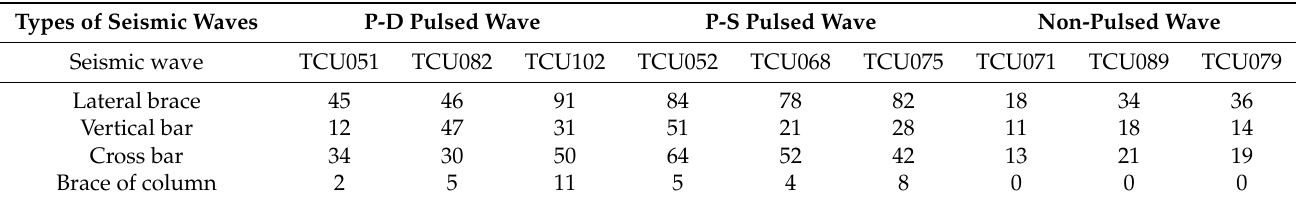
Table 4. The number of buckling of braces under rare ground